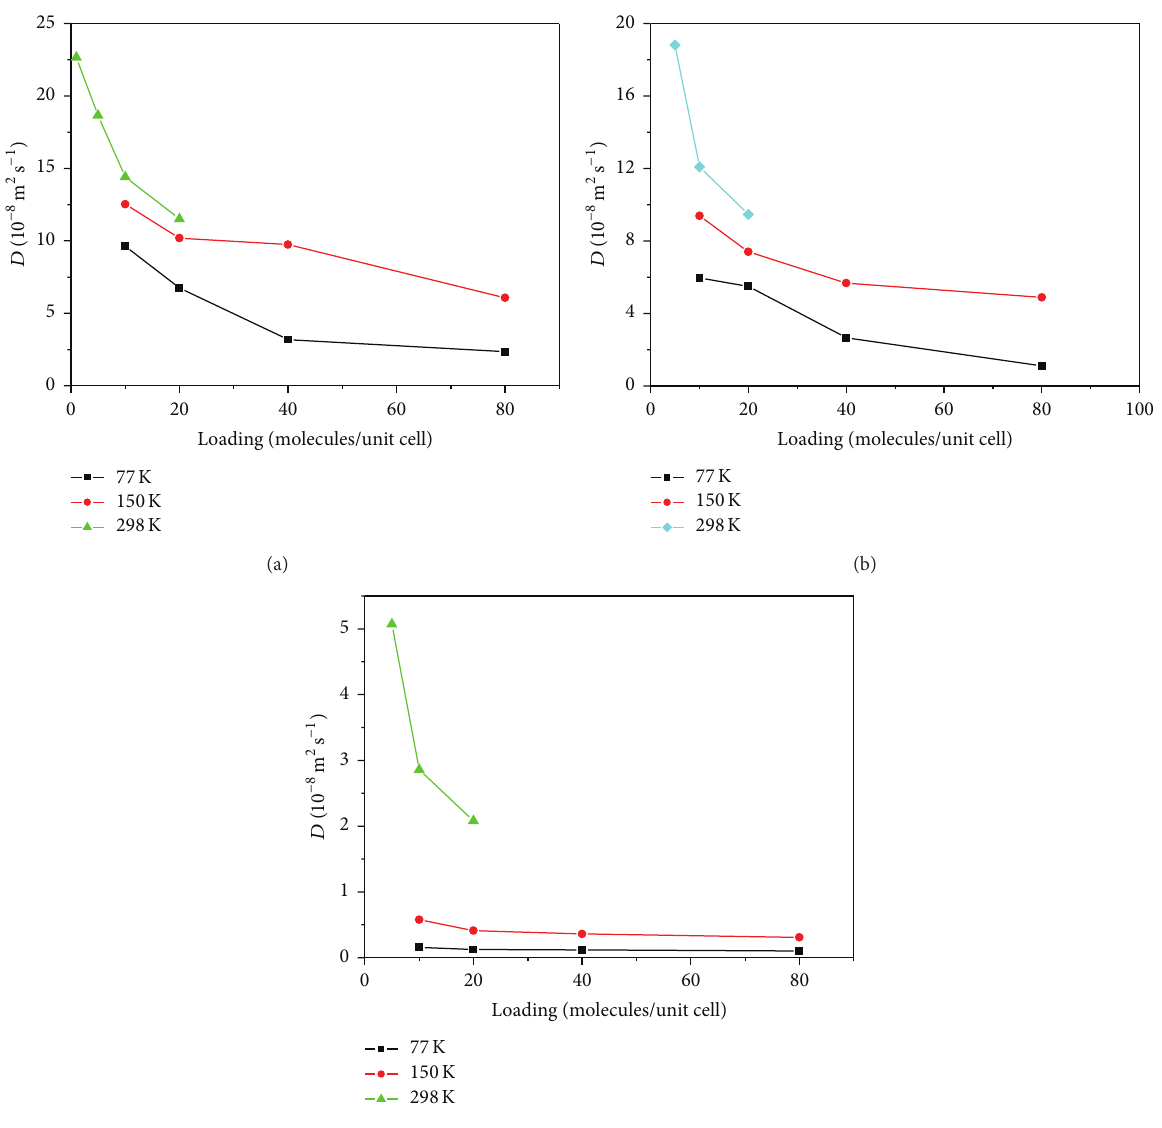
Figure 3: The self-diffusion coefficients of molecular hydrogen at different temperatures; (a) Ca 46 X, (b) Mg 46 X, and (c) Ba 46 X.